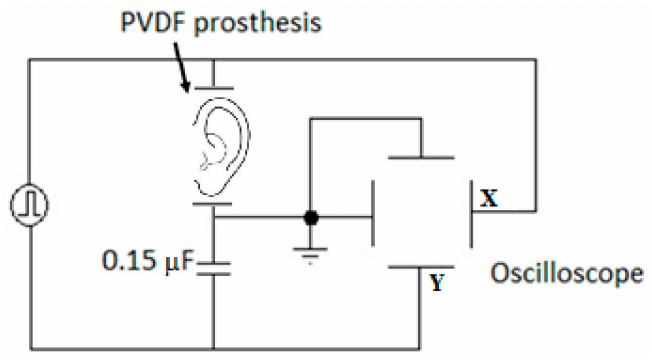
Figure 2. Measuring of the ferroelectric hysteresis loop using the Sawyer-Tower